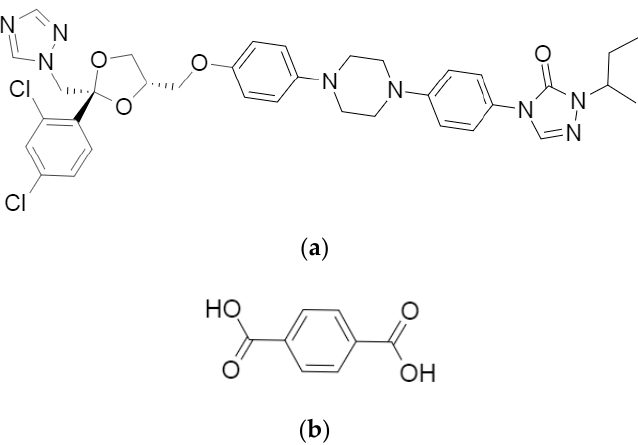
Figure 1. Molecular structures of ( a ) itraconazole (ITR) and ( b ) terephthalic acid (TER).